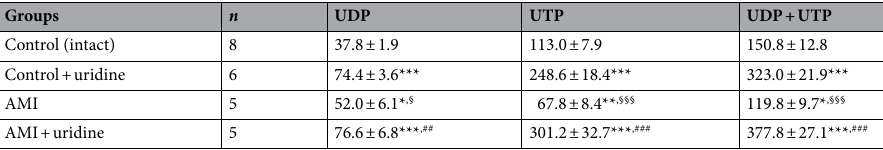
Table 1. Concentration of UDP and UTP (nmol/g wet tissue) in the myocardium of control rats and rats with AMI 65 min after administration of uridine. AMI, acute myocardial ischemia; UDP, uridine-diphosphate; UTP, uridine-triphosphateAll data are the mean ± SD ( n = 5–8). * p < 0.05 versus the control group; ** p < 0.01 versus the control group, *** p < 0.001 versus the control group; § p < 0.05 versus the control + uridine group, §§§ p < 0.001 versus the control + uridine group; ## p < 0.01 versus AMI group; ### p < 0.001 versus AMI group. Significance of differences was determined by a one-way ANOVA followed by the Turkey’s multiple comparison Post Hoc test.